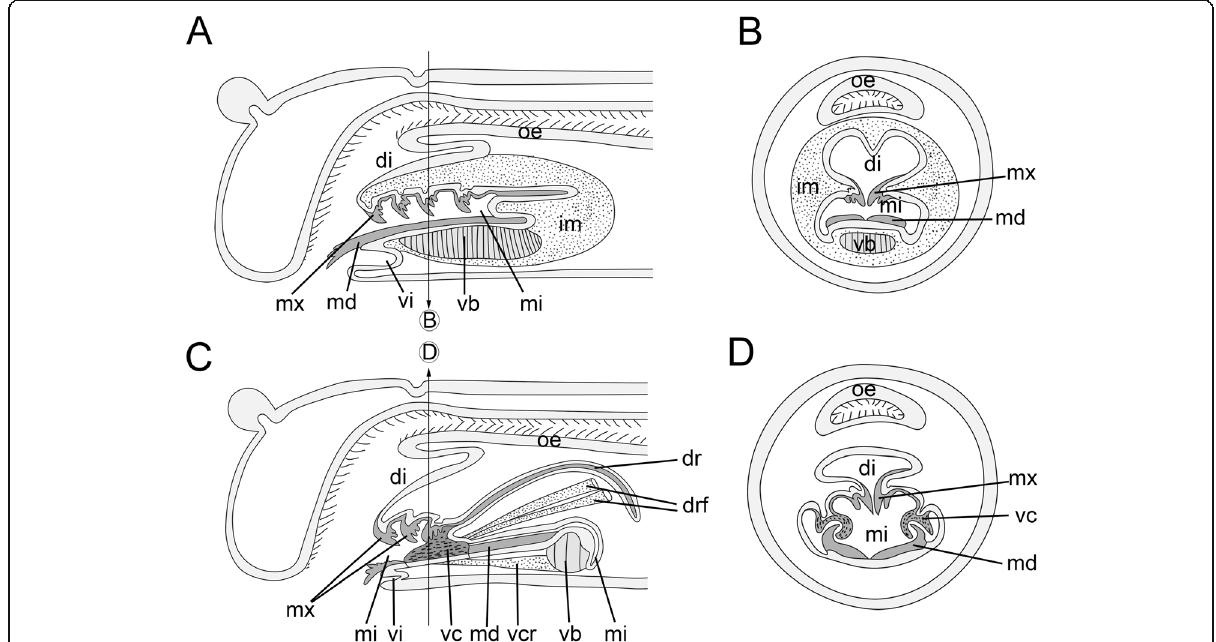
Fig. 4 Comparative schemes of the pharyngeal apparatuses in Dorvilleidae and Histriobdella homari . Arrows in ( a ) and ( c ) indicate the position of the transversal section. a. Dorvilleidae ( Ophryotrocha and Protodorvillea ); lateral view. b. Dorvilleidae ( Ophryotrocha and Protodorvillea ); cross- section. c. Histriobdella ; lateral view. d. Histriobdella ; cross-section. The schematic representation is modified from [9]. di, dorsal invagination; dr, dorsal rod; drf, dorsal rod flexor; im, investing muscles; md, mandibles; mi, median invagination; mx, maxillae; oe, esophagus; vb, ventral muscle bulb; vc, ventral carriers; vcr, ventral carrier retractor; vi, ventral